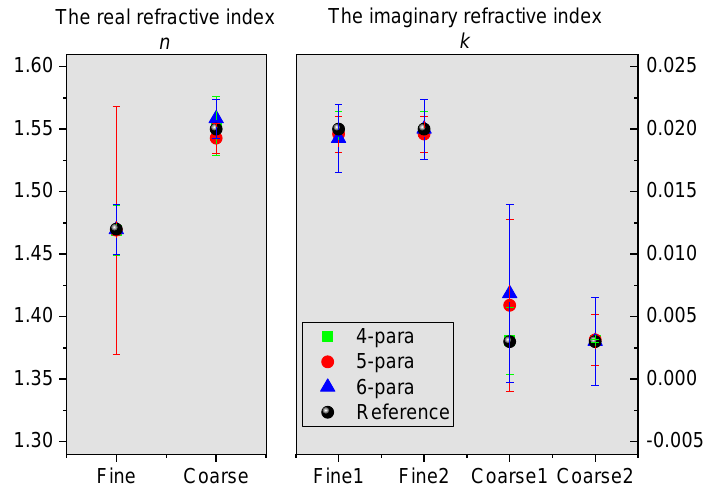
Figure 7. Comparison of estimated modal aerosol refractive index values calculated using different numbers of parameters (4, 5, or 6) with the reference values. Fine1 and Coarse1 refer to 0.44 µ m and Fine2 and Coarse2 refer to 0.67–1.02 µm.